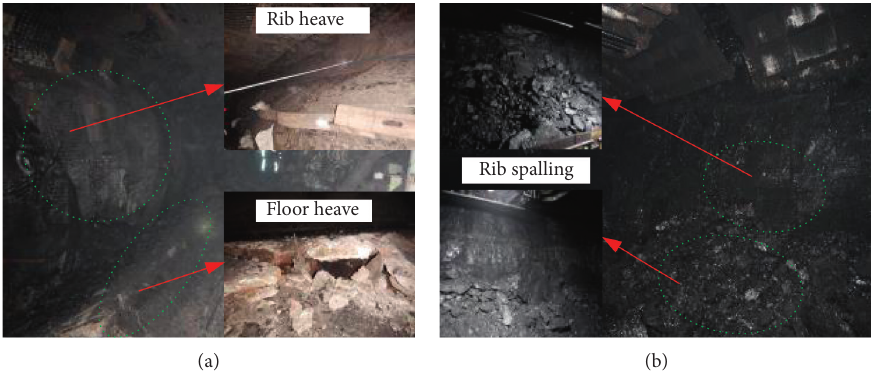
Figure 3: Strong ground pressure manifestations.